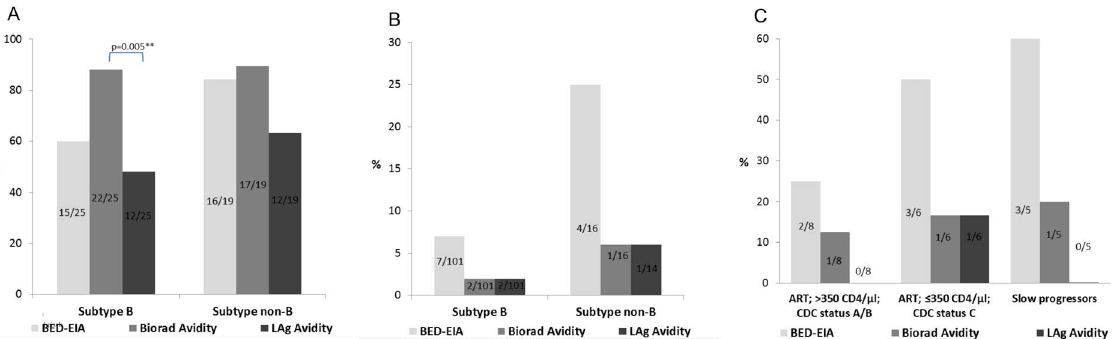
Figure 2. Comparison of BED-CEIA, Bio-Rad and LAg-Avidity assay results according to subtype, clinical stage and disease progression. True recent ratios within the ‘recent infections set’ subtype B and ‘non-B’ (A). False recent ratios among long-term subtype B and ‘non- B’ infected, ARV-naı¨ve individuals (B). Misclassification in the ‘challenge specimens’ set (C). Only significant p-values ( , 0.05) of pairwise comparisons were indicated.